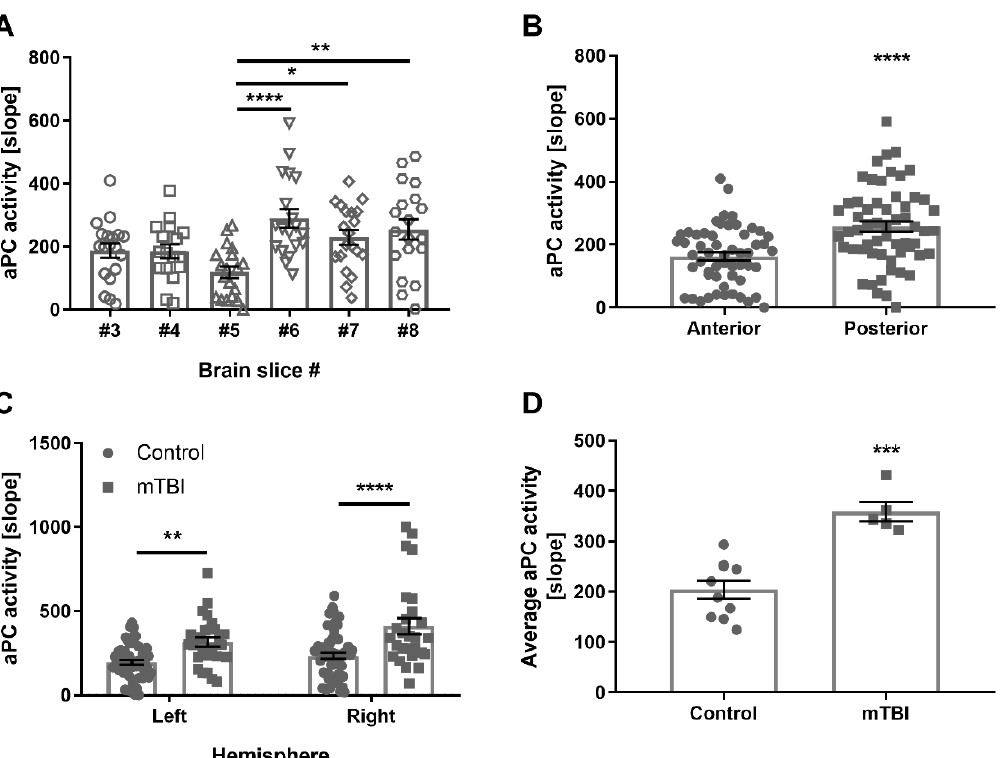
Figure 3. APC activity in mouse brain. ( A ) APC activity across healthy mouse brain: APC activity varies across the brain ( n = 17–20, p < 0.0001). The highest activity was measured in brain slice #6, and it is significantly higher compared to brain slice #5 ( n = 19, p < 0.0001). ( B ) APC activity in anterior versus posterior healthy brain slices: Posterior brain slices (#6–8) present significantly higher APC activity compared to anterior brain slices (#3–5) ( n = 55–58, p < 0.0001). ( C ) APC activity in the brain 24 h after mild traumatic brain injury (mTBI): APC activity in brain slices following mTBI was significantly higher in the right and the left hemispheres, compared to control ( n = 58, 56, and 27, respectively, p < 0.0001 and 0.0053, respectively). ( D ) average APC activity 24 h after mTBI: The average APC activity across the brain was significantly higher after mTBI compared to control ( n = 5 and n = 10, respectively, p < 0.0001).